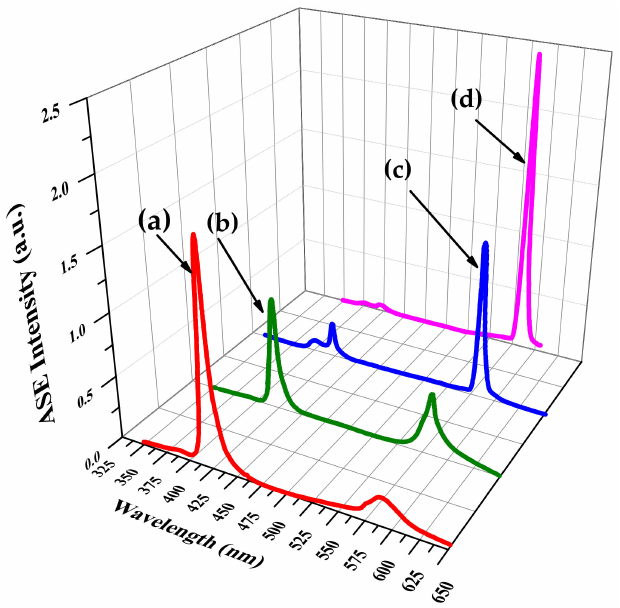
Figure 8. Energy transfer from oligomer to TCP; the concentration of donor and acceptor was ( a ) 9 µ M/0.72 µ M, ( b ) 8 µ M/1.6 µ M, ( c ) 7.6 µ M/1.8 µ M, and ( d ) 6.7 µ M/2.7 µ M at 20 ◦ C.